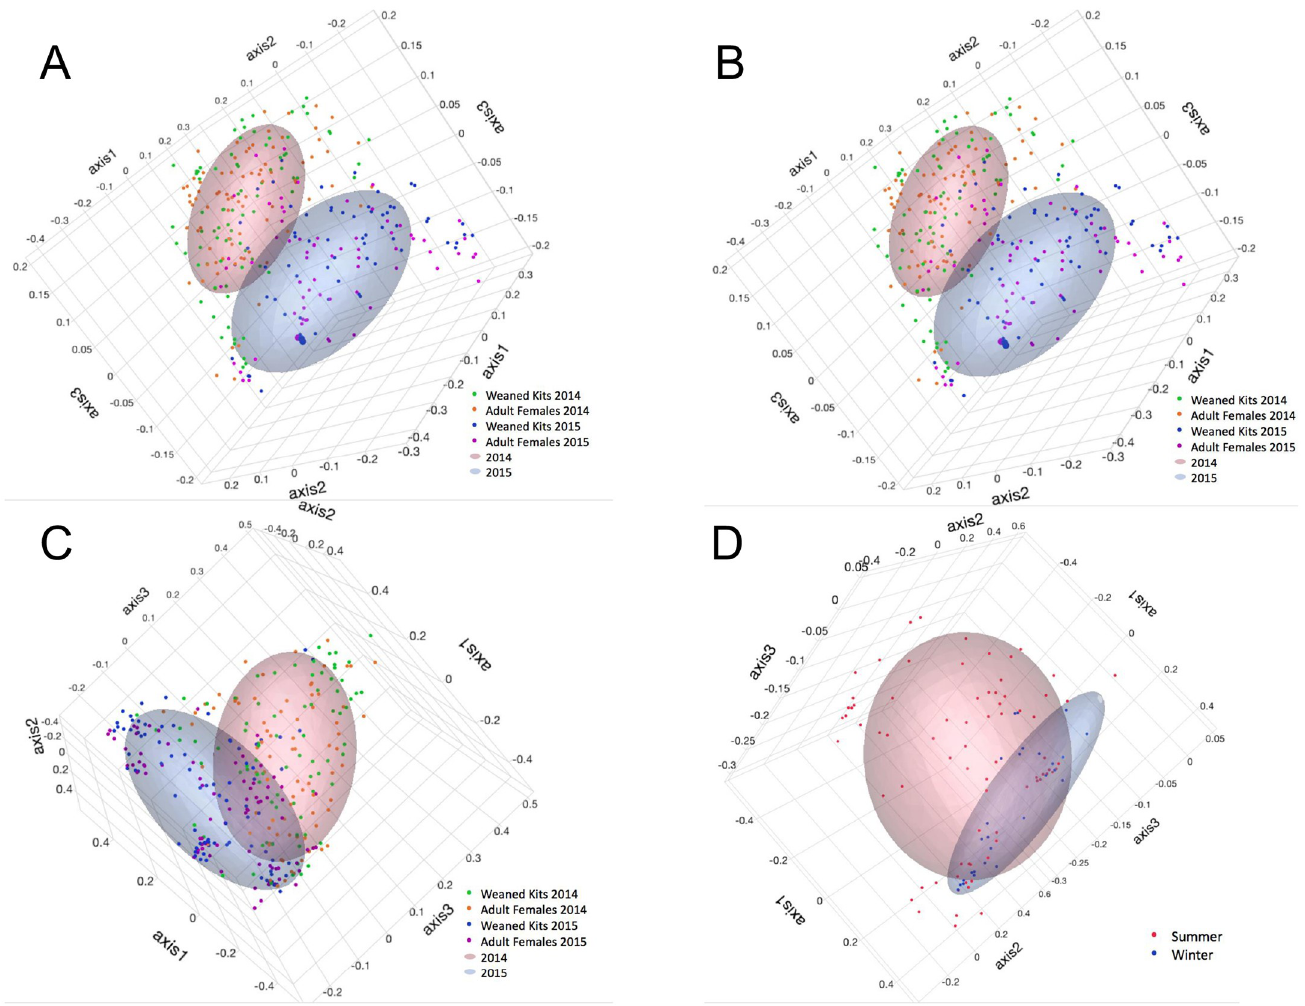
Fig 2. Principal coordinate analysis (PCoA) of community population based on the Jaccard Index (a and b) and community structure based on the Yue- Clayton Index (c and d) of the fecal microbiota of commercial mink, by year (n = 332) (a and c) and season (n = 117) (b and d). Samples were obtained from 43, 46, and 39 farms in 2014, 2015, and 2016, respectively.